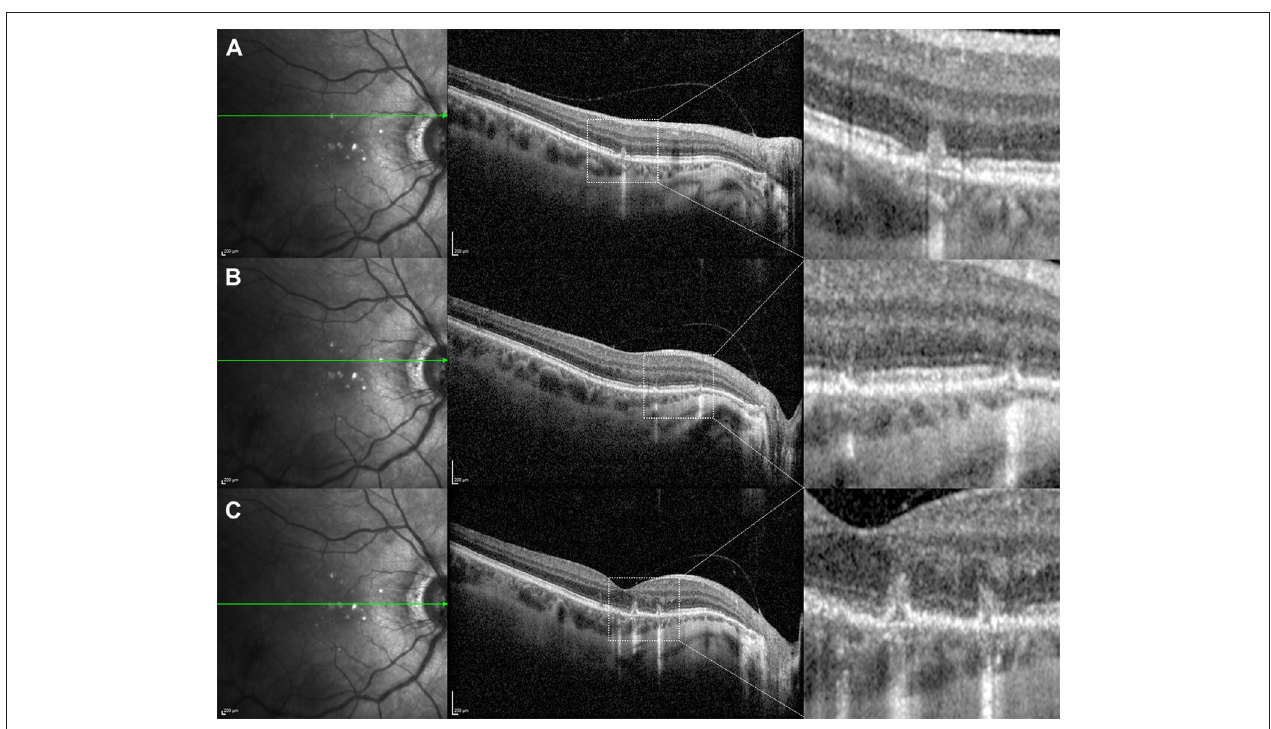
FIGURE 4 | Optical coherence tomography (OCT) assessment of the macula in a 42-year-old female myopic patient complaining of scintillating scotoma in her right eye, showing typical structural changes of acute multifocal choroiditis lesions. (A) Superior OCT scan reveals a focal disruption of the retinal pigment epithelium (RPE) layer leading to choroidal hypertransmission, with subtle elevation of the borders; this is associated with external limiting membrane (ELM) and photoreceptors ellipsoid zone disruption, and hyperreflective subretinal and sub-RPE material. (B) OCT scan immediately superior to the fovea reveals two small RPE disruptions with secondary choroidal hypertransmission, and disruption of the photoreceptors ellipsoid zone with preservation of ELM, corresponding with early inflammatory lesions. (C) Foveal-centered OCT scan reveals two small RPE disruptions with elevation of the RPE borders, underlying choroidal hypertransmission and subretinal hyperreflective material in an area of ELM and photoreceptors ellipsoid zone disruption.